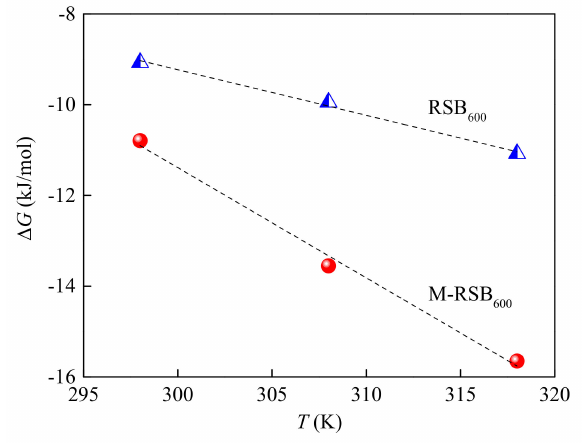
Figure 13. Adsorption thermodynamic fitting of RSB 600 and M-RSB 600 for MB. Table 6. Adsorption thermodynamic parameters of RSB 600 and M-RSB 600 for MB. ∆ G Adsorbent